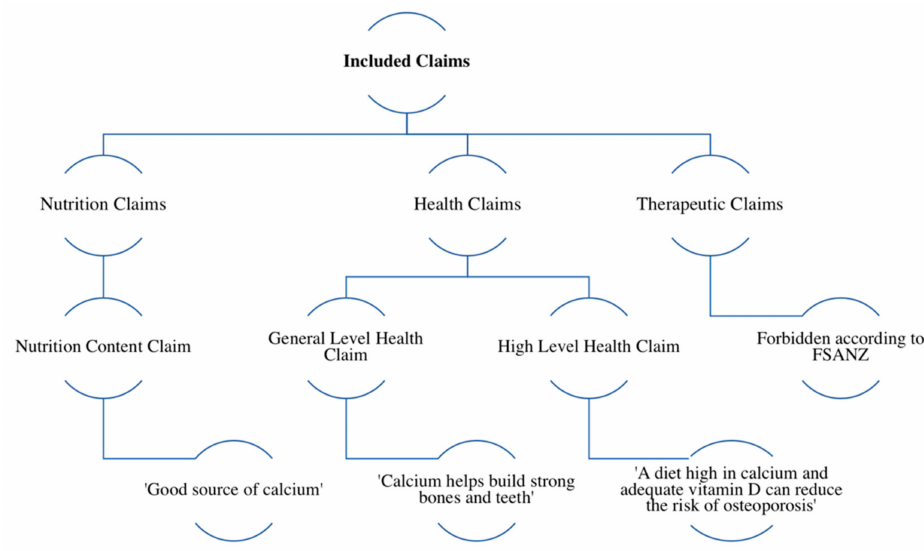
Figure 1. Examples and summary of claims included in this study as defined by the Food Standards Code